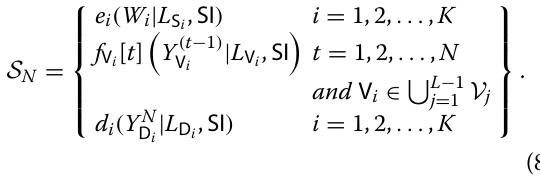
Fig. 2b in three time slots. Thus, with interference avoid- ance, one can only achieve α = 1 which is the same as 3 TDMA. However, we show that it is possible to recon- struct the three induced subgraphs in only two time slots and to achieve α = 1 with 1-local 2